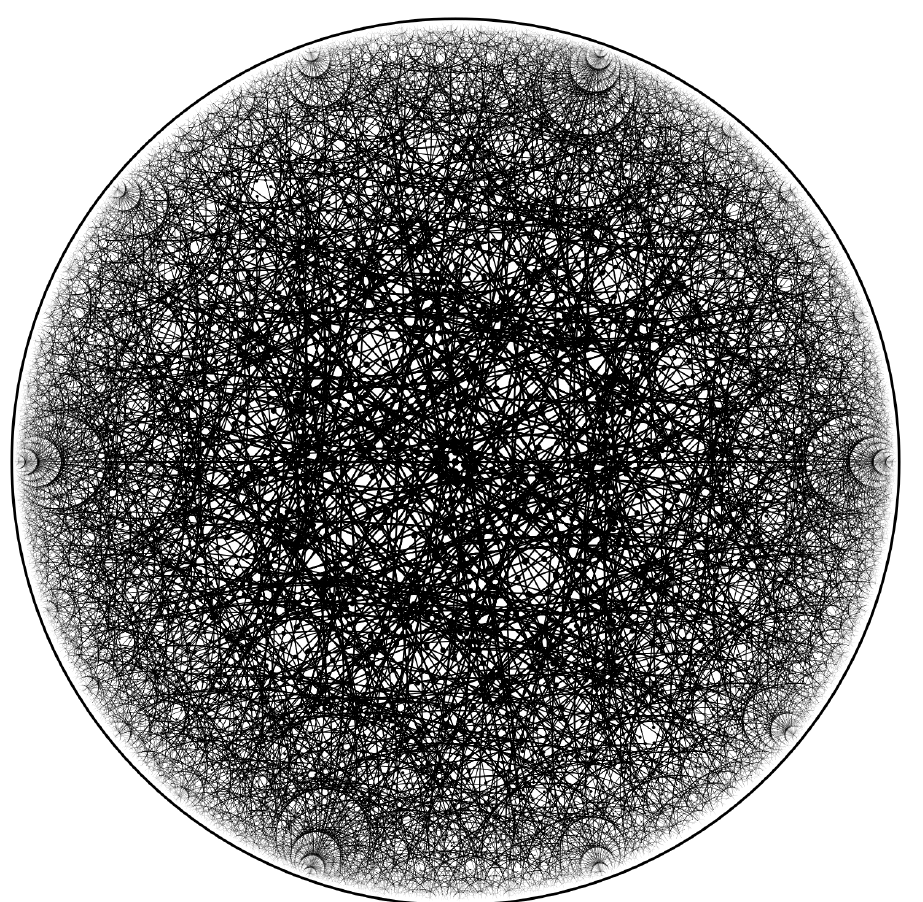
Figure A3. M (cid:63) , a Poincaré disk succeeding the disks shown in Figure 9